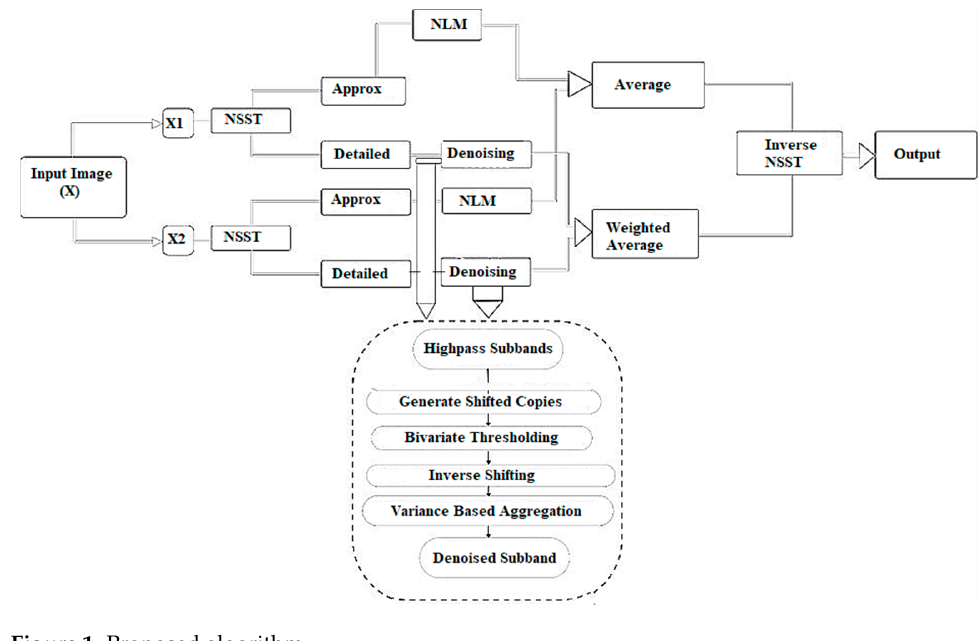
Figure 1. Proposed algorithm.